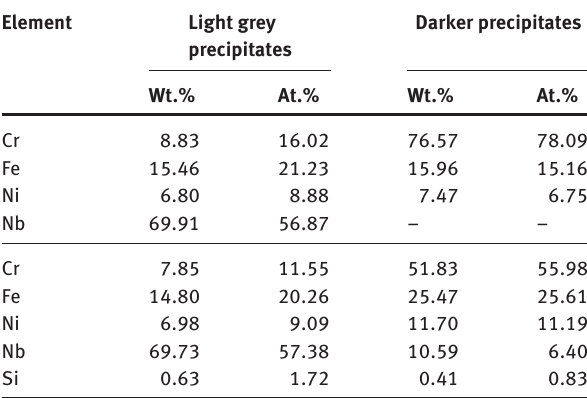
Table 8: SEM-EDAX results of composition in precipitate phases present [34].